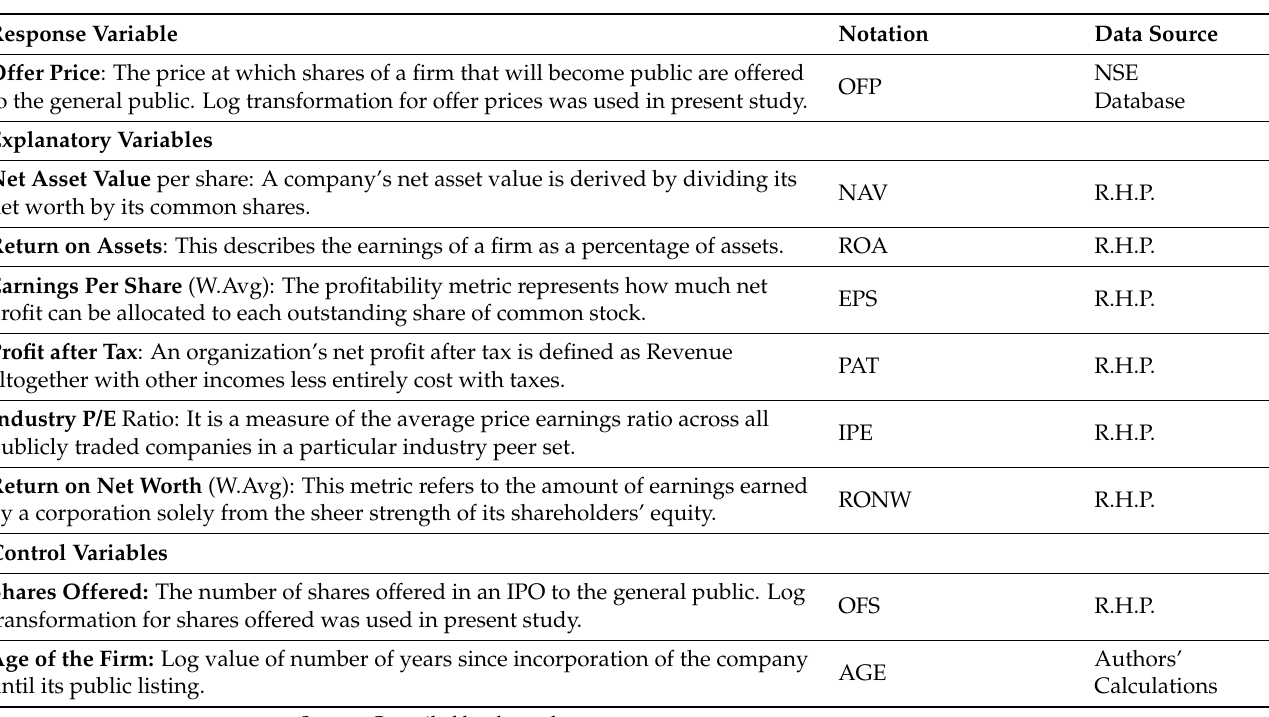
Table 2. Variables and their